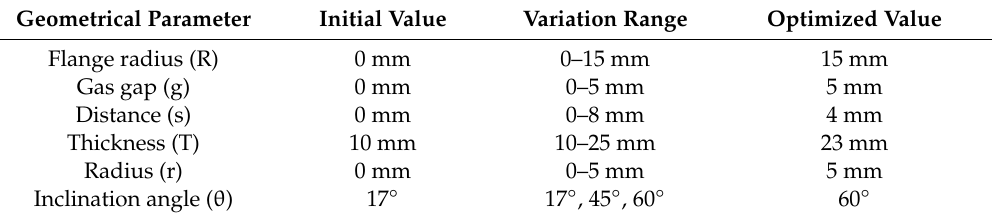
Table 1. Controlled geometrical parameters and final optimized